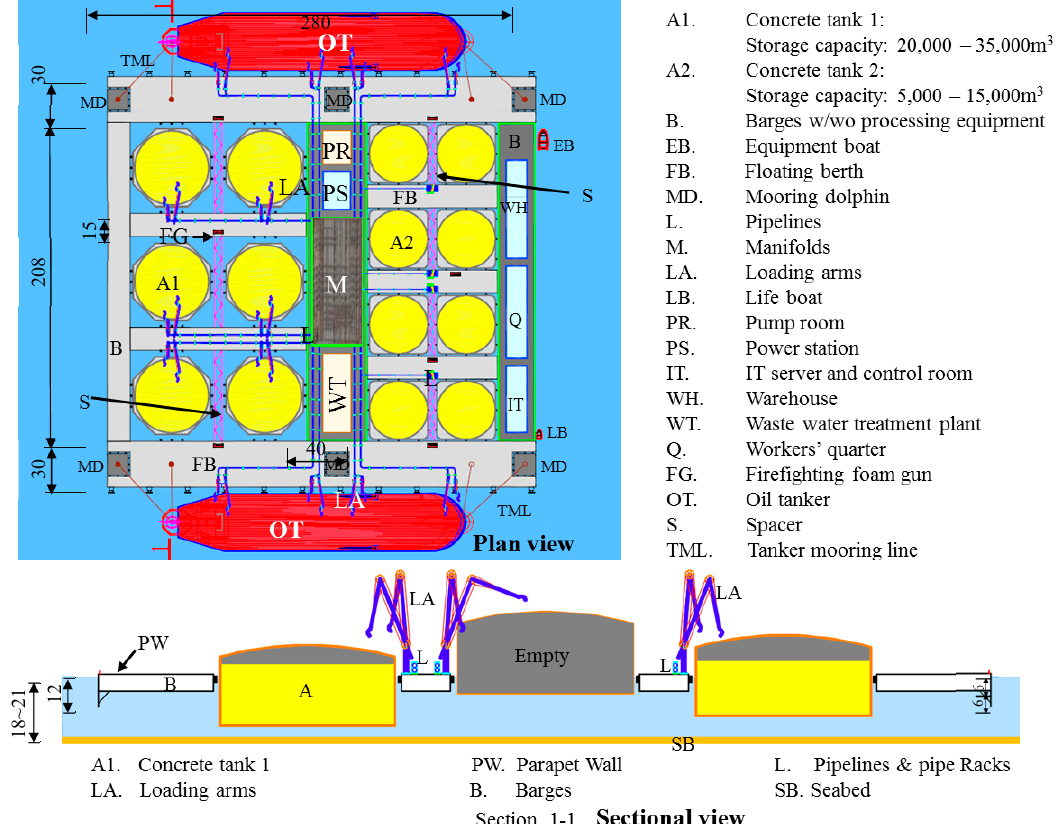
Figure 6. Plan and sectional views of FHSBF.